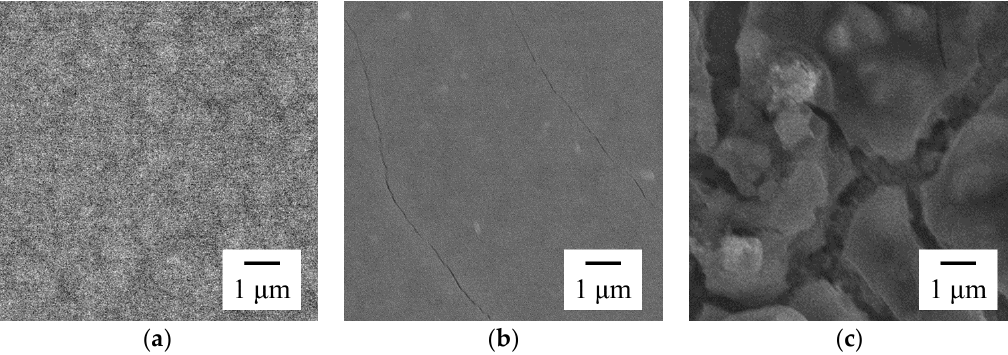
Figure 12. SEM images of Zn–Fe–Mo plating deposited at various Mo concentration. ( a ) 0.01 mol dm −3 ; ( b ) 0.02 mol dm −3 ; and ( c ) 0.1 mol dm −3 .